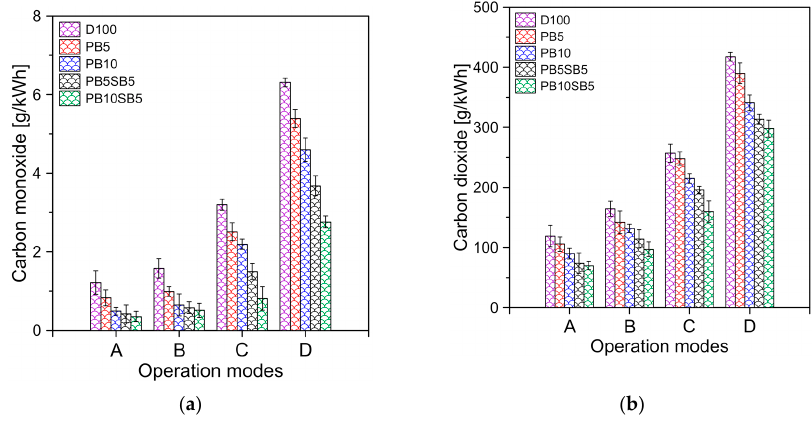
Figure 10. ( a ) CO and ( b ) CO 2 emissions for fuels tested.